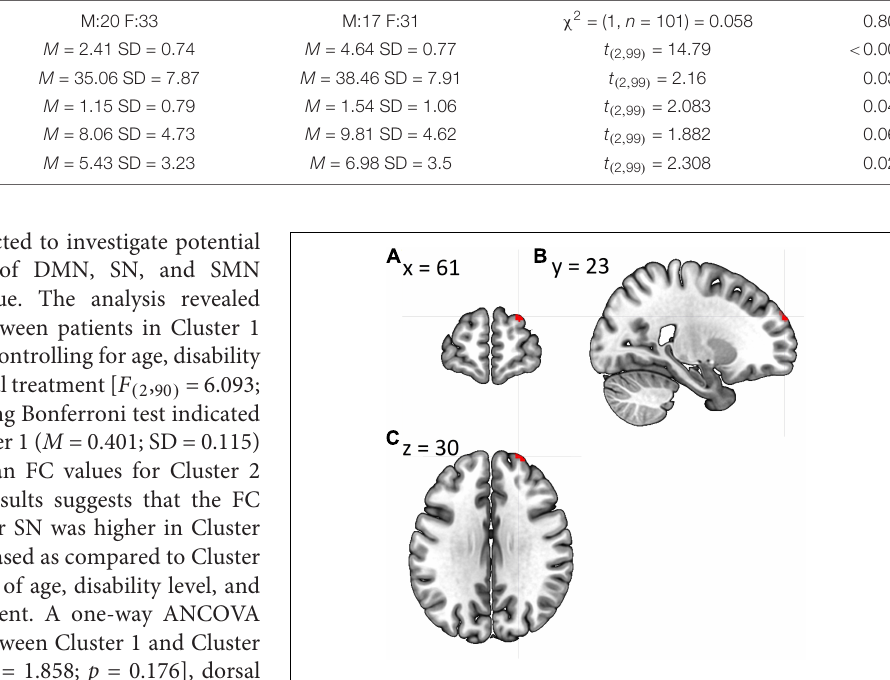
TABLE 1 | Demographic and medical data of patients in clusters. Cluster 1 Cluster 2 Test result